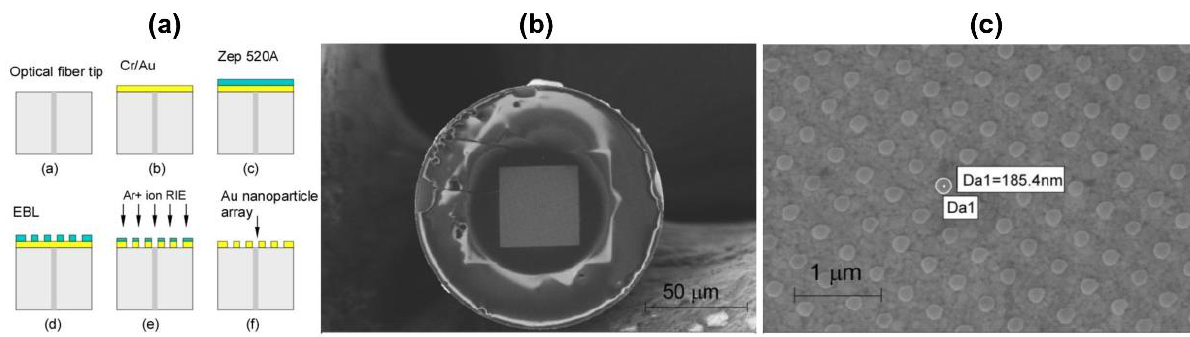
Figure 2. Fabrication process for gold nanodots arrays on the optical fiber tip ( a ), scanning electron micrograph of the gold nanodot array on the optical fiber ( b ) and gold nanodot array on the optical fiber facet ( c ). The figure in Lin et al. [33] is reprinted with permission from Multidisciplinary Digital Publishing Institute (MDPI).